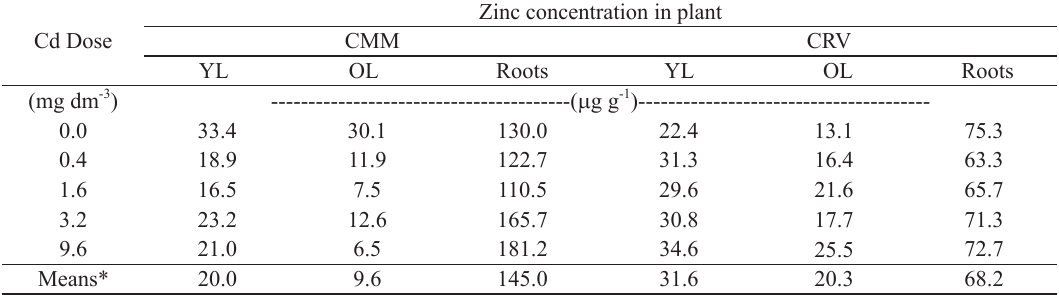
Concentrations of Zn in young (YL) and old (OL) leaves and roots of lettuce cultivars (CMM and CRV), 44 days after seedlings transplanting to soil treated with Cd doses.